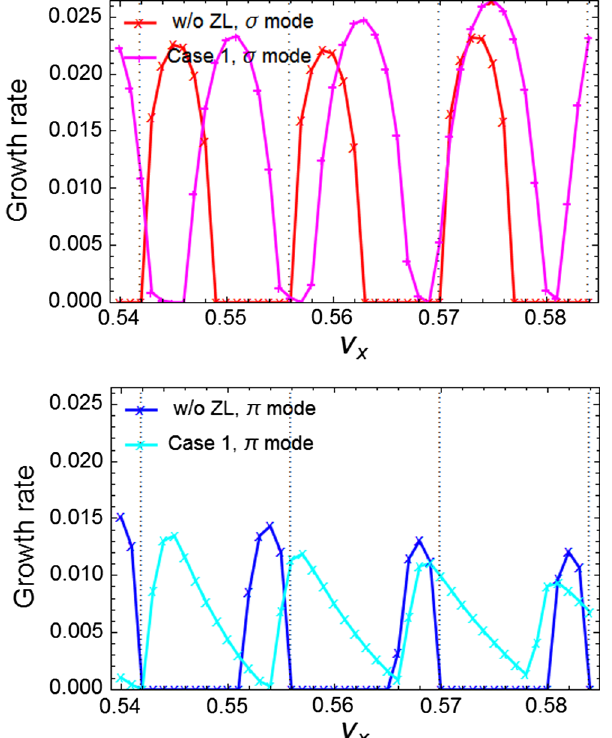
FIG. 15. Comparison of growth rate between case 2 and case without longitudinal impedance for σ = π modes. In case 2, we consider the distortion of elliptical trajectory but keep the ð J Þ ¼ 0 . 014 synchrotron tune constantly ν s